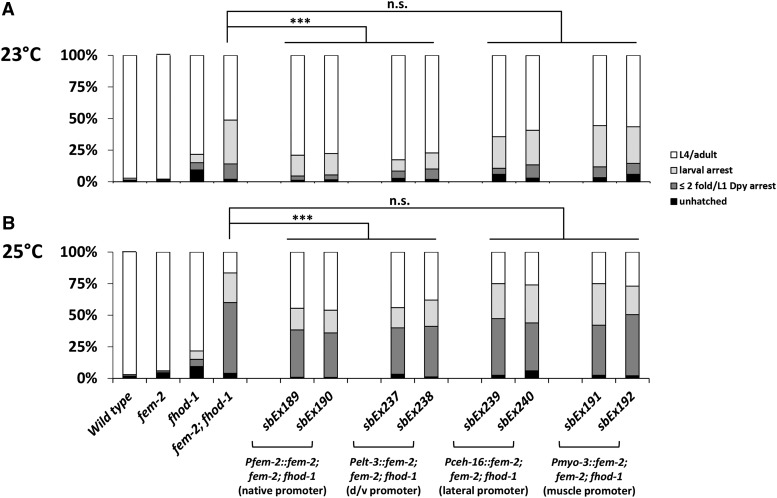
Tissue-specific rescue of fem-2. Extrachromosomal arrays contained constructs of the fem-2 cDNA driven by the fem-2 promoter, the elt-3 promoter (dorsal/ventral epidermal cells), the ceh-16 promoter (lateral epidermal cells) or the myo-3 promoter (body wall muscle). Two independent lines for each construct were cultured at 23° (A) or 25° (B) and scored for growth to the indicated stages as described in MATERIALS and METHODS. As fem-2 elongation phenotypes are low penetrance, fhod-1(tm2363) was included to sensitize the strains. At both temperatures, the native and dorsal/ventral promoters rescued elongation phenotypes to similar degrees (*** = P < 0.001 by One Way ANOVA of the animals that grew to L4/adult) while the lateral and muscle promoters did not (n.s. = non-significant, P > 0.05).